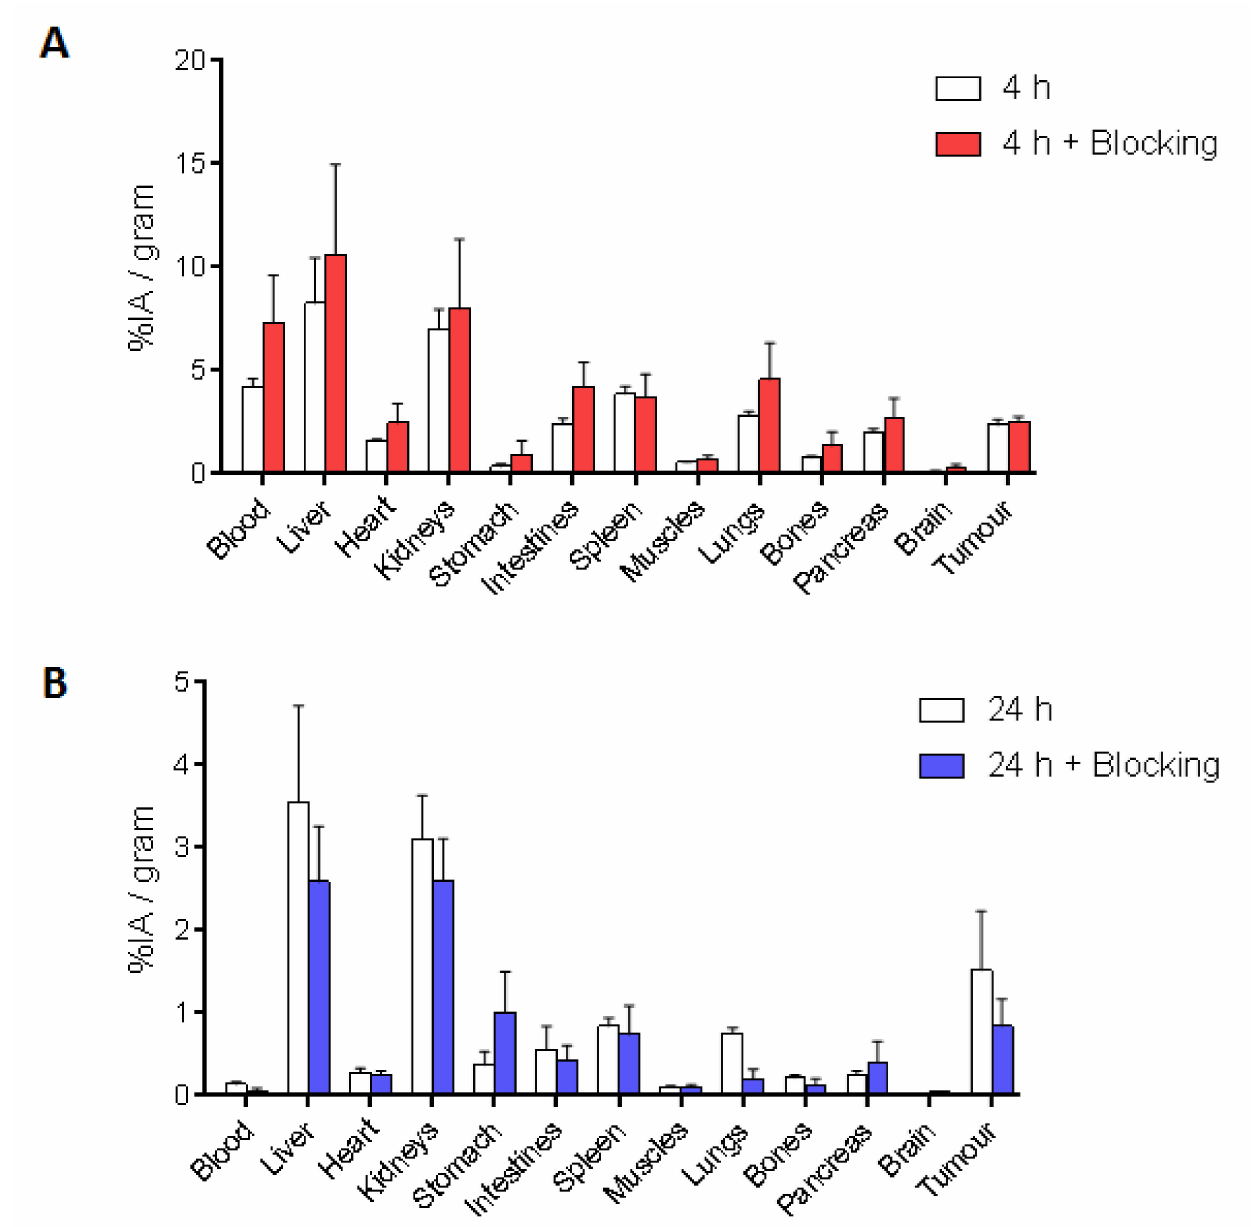
Figure 5. Comparison among the biodistributions in multiple organs of [ 111 In]In-IP-001 and [ 111 In]In-IP-001, as well as unlabeled-IP-001 (blocking) in A549 cancer-bearing nude mice ( n = 3; mean ± SD) at 4 ( A ) and 24 h ( B ) post